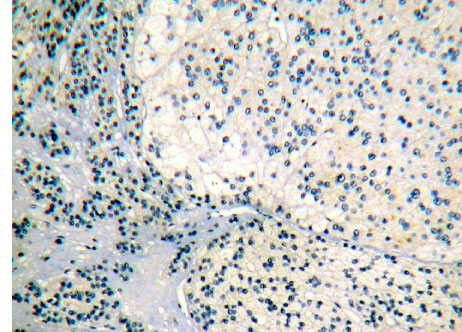
Adrenocortical hyperplasia PCNA(—) SuperisionTM